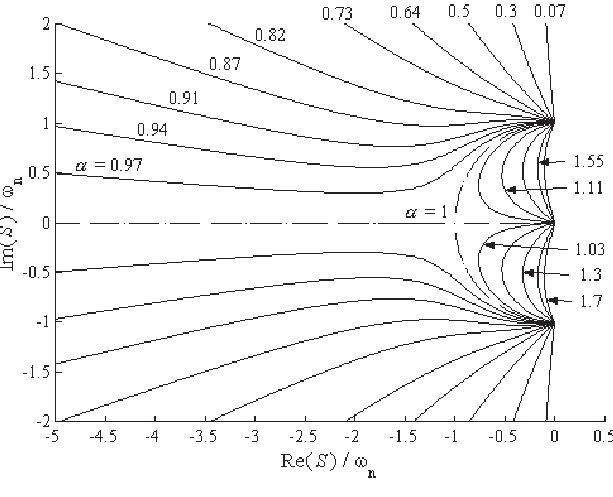
Fig. 3. Root locus of the fractional derivative damped SDOF system in function of α